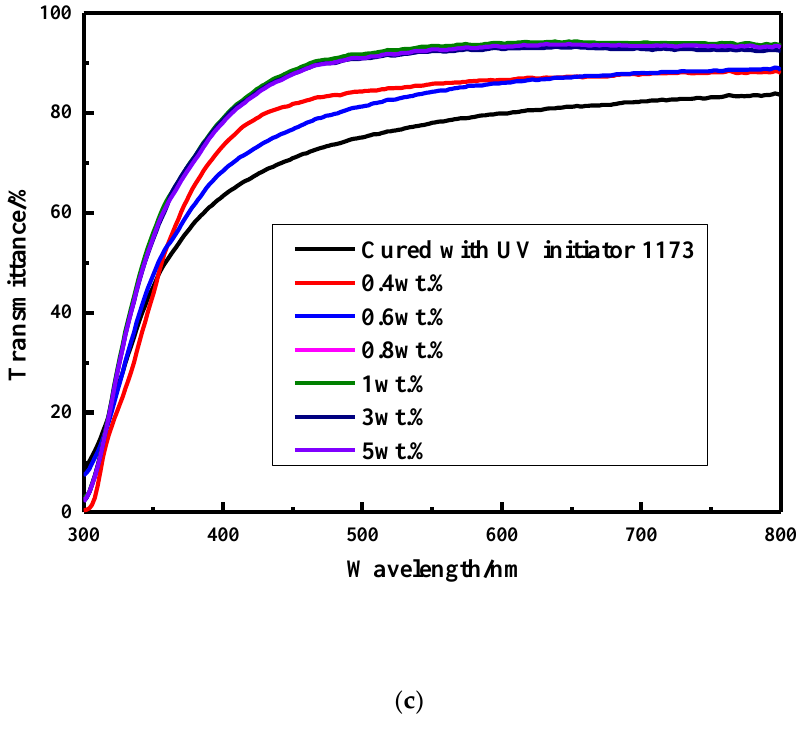
Figure 10. Transmittance of coatings before and after UV–aging. ( a ) Transmittance of the coatings before UV–aging; ( b ) transmittance of the coatings after UV–aging at room temperature for 35 min. ( c ) transmittance of the coatings after UV–aging at 100 °C for 21 min.